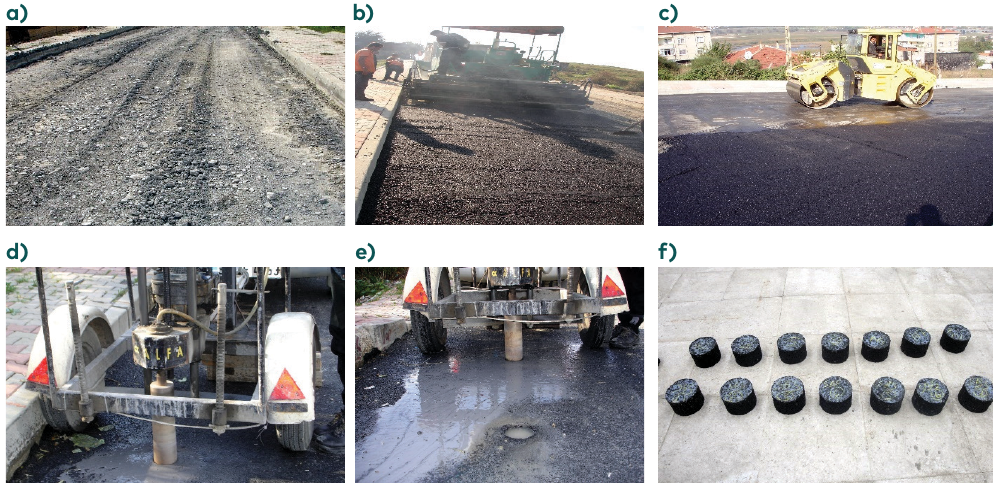
Figure 1. Field work tasks to obtain samples: a) laying out of base layer, b) asphalt pavement layer, c) compression of the asphalt pavement layer, d) core sample machine, e) taking core samples, and f) Marshall